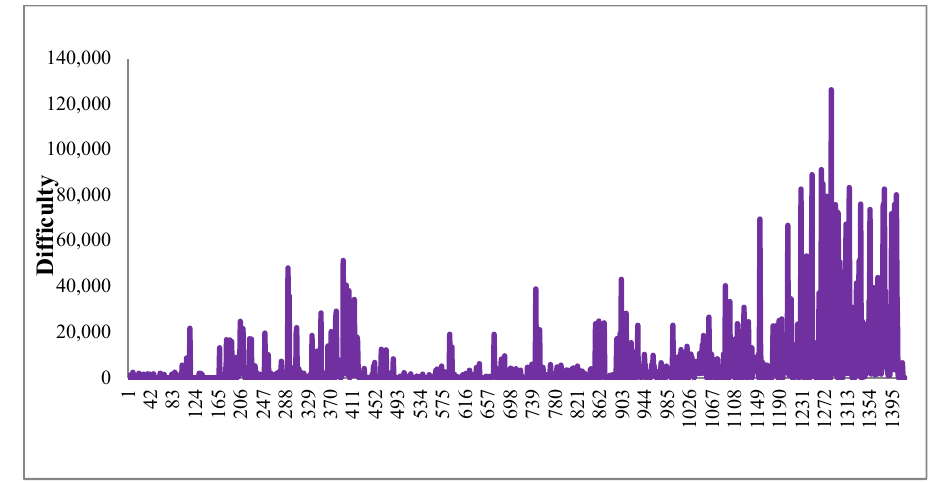
Figure 12. Difficulty of every slot allocation while weights set as [0,0.5,0.5] in test 8. Figure 12. Di ffi culty of every slot allocation while weights set as [0,0.5,0.5] in test